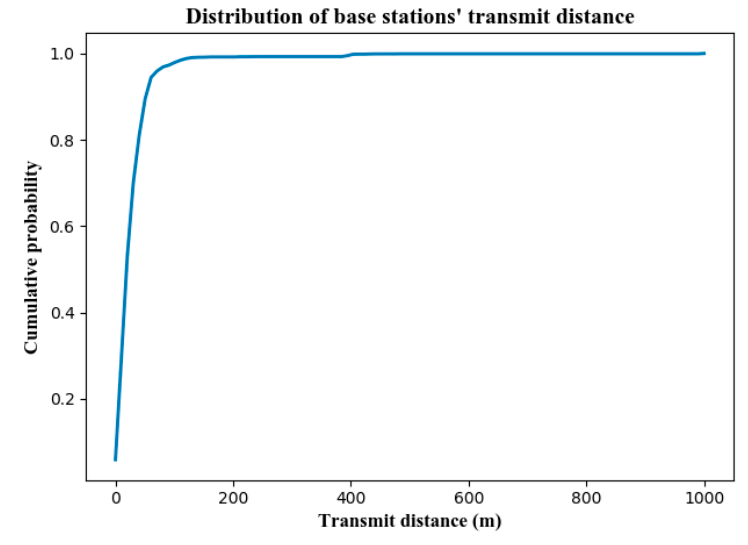
Figure 17. The distribution of transmitting distance between base stations and mobile devices in our testing experiment.